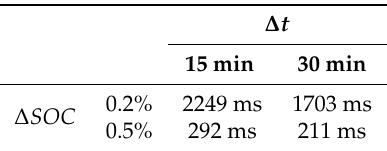
Table 3. Execution time of the Online Replanning task (First